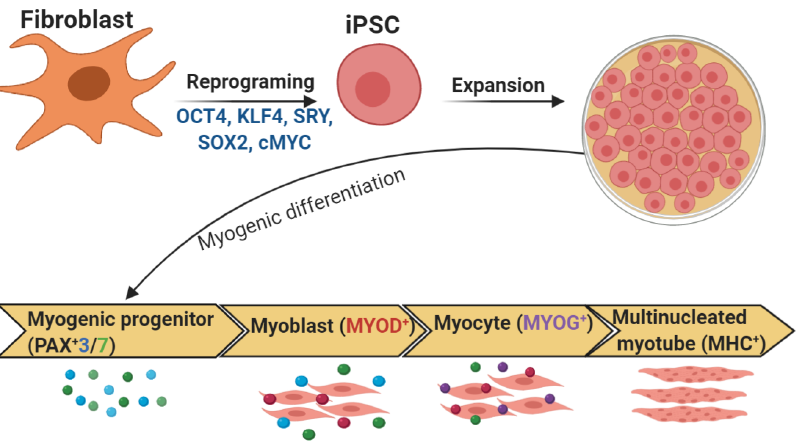
Figure 4. In vitro differentiation of myotubes from iPSCs. Addition of a number of large or small molecules induces each stage of differentiation, which is monitored by expression of key transcription factors during the consecutive stages of